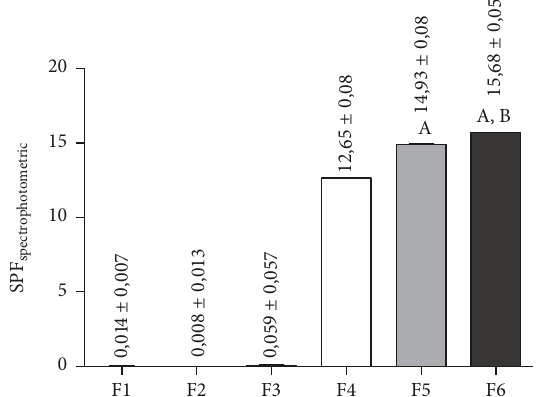
Figure 2: Determination of Sun Protection Factor (SPF) spec- trophotometric of cosmetic formulations (F1–F6). Results are expressed as mean ± SD ( 𝑛 = 3 ), where A (𝑝 < 0.05 , F5 or F6 versus F4) and B (𝑝 < 0.05 , F5 versus F6), according to one-way ANOVA followed by Tukey’s